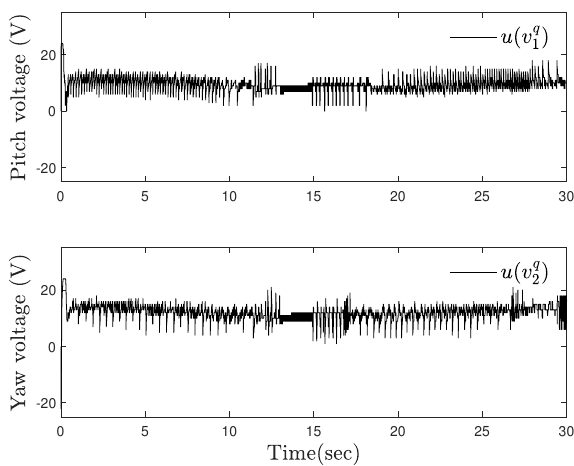
Figure 4. Control input voltages V p and V y for simulation.